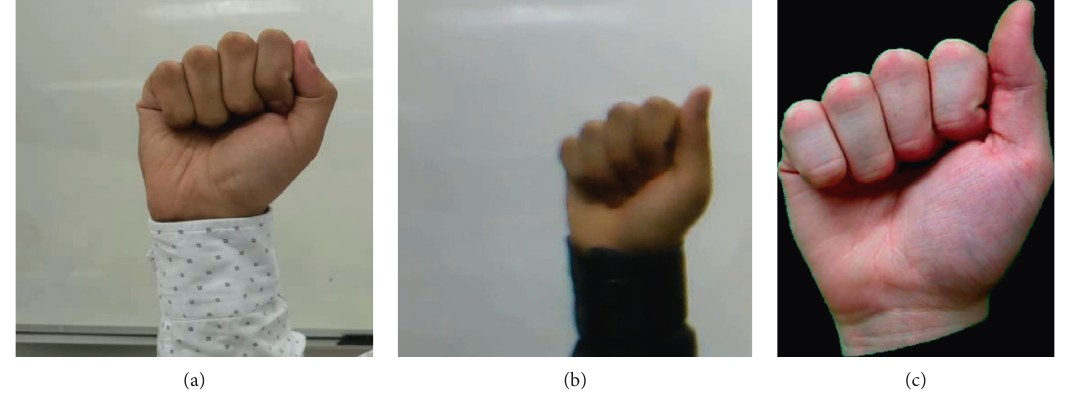
Figure 4: Samples for gesture